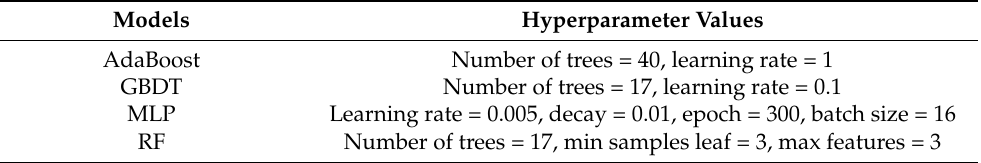
Table 2. The optimized hyperparameter values for the selected four models.